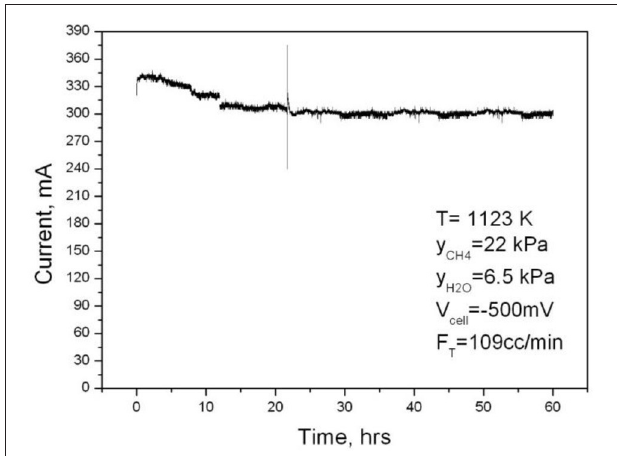
FIGURE 11 | Short term stability test of the anode at T = 1,123K, S/C < 0.33 and operating voltage V cell = − 500mV. Reprinted with permission from Gavrielatos et al.